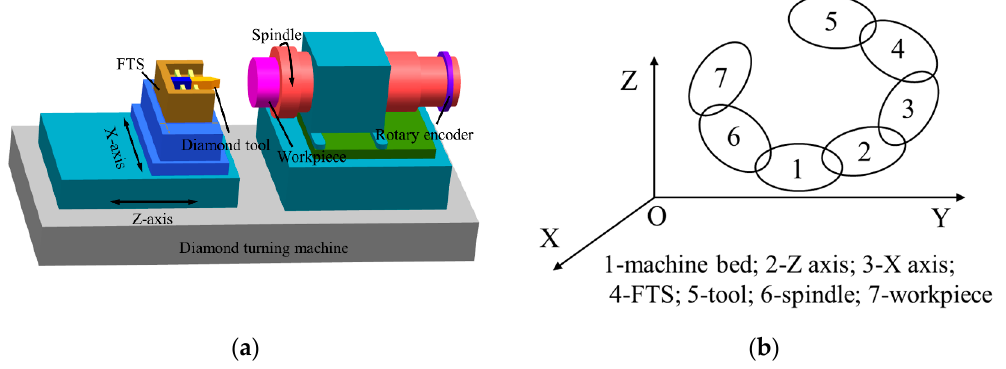
Figure 1. ( a ) Schematic diagram and ( b ) Kinematic chain diagram of the fast tool serve (FTS) turning